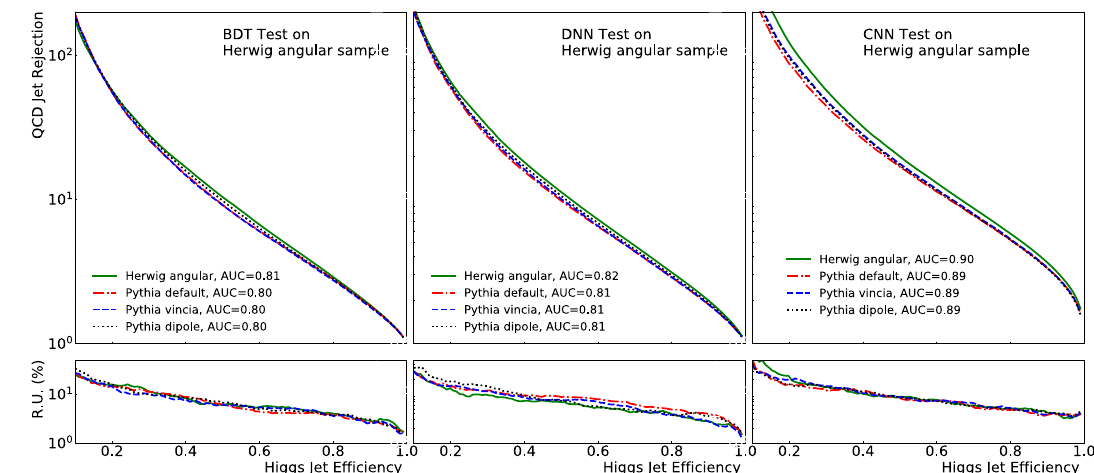
Fig. 4 The QCD rejection (inverse QCD efficiency) as a function of the Higgs jet efficiency for classifiers applied to Herwig angular jet from four PSMC algorithms. The bottom panel shows the relative uncertainties